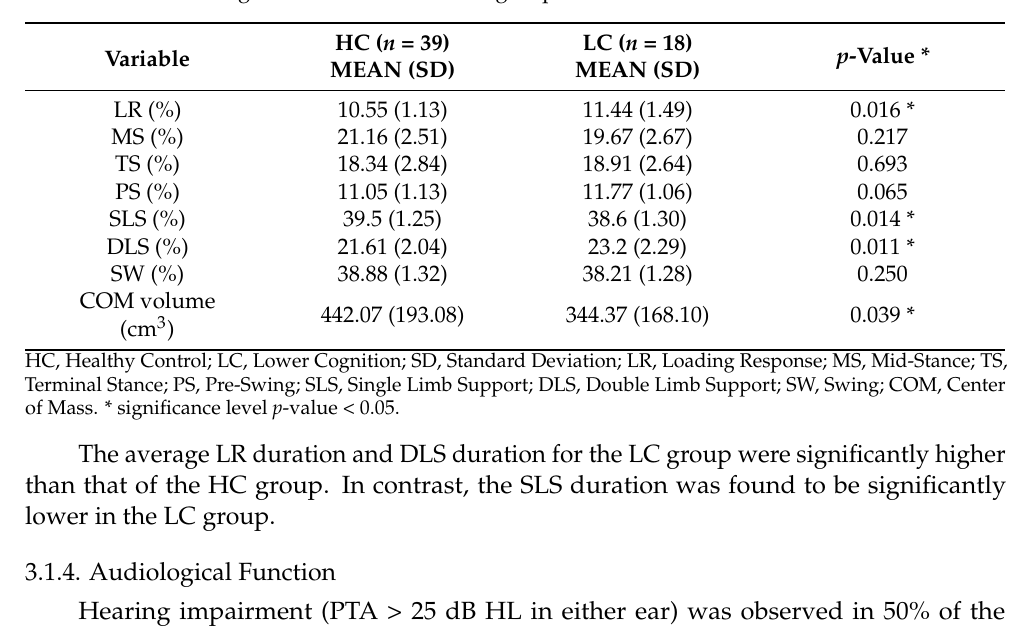
Figure 3. Visualization of three-dimensional COM trajectory: ( a ) HC and LC average COM trajectory, and ( b ) example of the volume encompassed by the COM trajectory. Table 3. Level walking variables of LC and HC